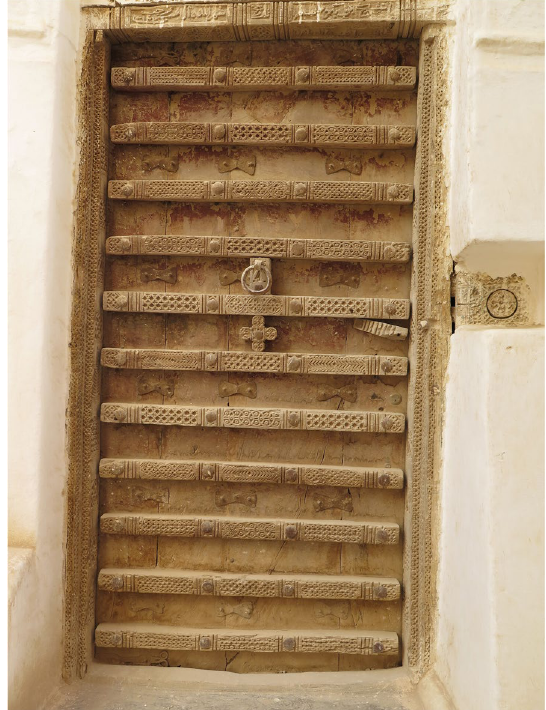
Fig. 6 Shibam, wooden entrance door detail (Source: the